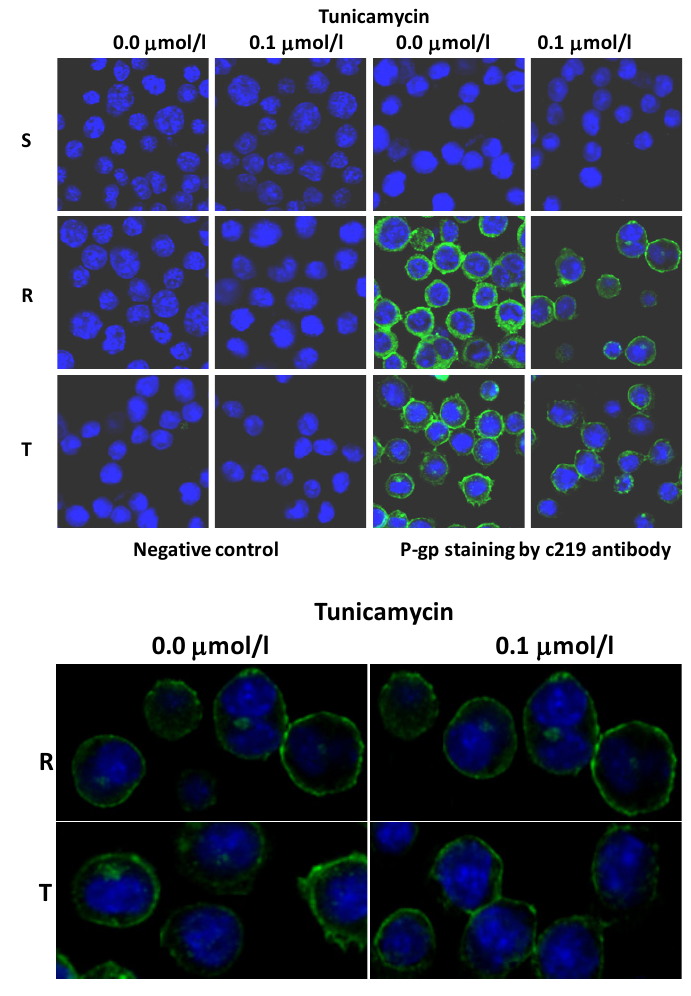
Figure 4. ( a ) Visualization by immunofluorescence confocal microscopy of the localization of P-gp in cells cultivated for three passages in the absence or presence of tunicamycin . Nuclei were stained using 4',6-diamidino-2-phenylindole (blue). P-gp was detected using the c219 anti-P-gp antibody and a FITC-conjugated anti-mouse secondary antibody (green). In the negative control, the c219 antibody was omitted, and the cells were incubated with a FITC-conjugated anti-mouse secondary antibody alone. These data are representative of three independent measurements. ( b ) Cells from the same experiments in ( a ) at a higher